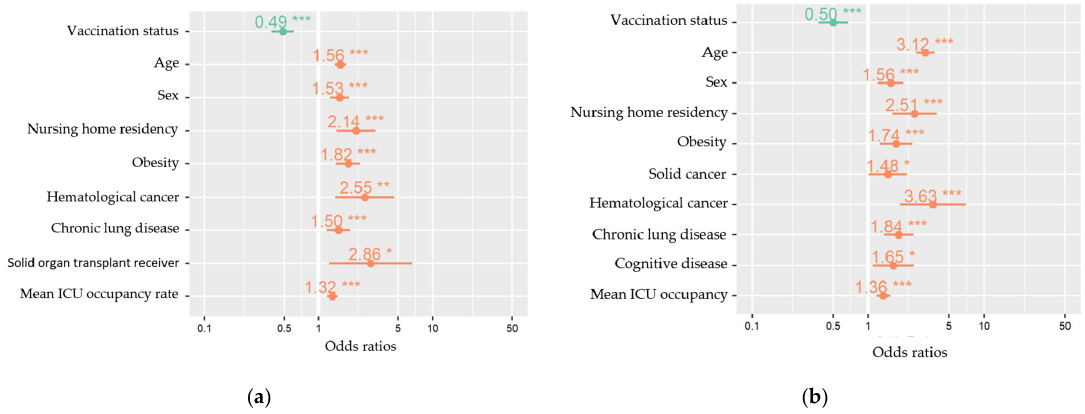
Figure A1. Multivariable mixed-effects models for explanatory variables (fixed effects) of severe COVID-19 ( a ) and in-hospital death ( b ) among hospitalized COVID-19 patients, COVID-19 clinical hospital surveillance. The following fixed effects were retained in the models obtained after stepwise backward elimination of non-significant ( p < 0.05) variables: vaccination status (primary vaccination course compared to unvaccinated), age (years), sex (male compared to female), nursing home residency, obesity, hematological cancer, chronic lung disease, and mean ICU occupancy rate (%). For the outcome severe COVID-19 ( a ), solid organ transplantation was additionally retained and for in-hospital death ( b ) additionally cognitive disease was retained. Hospital was added as a random effect to the model. ICU = intensive care unit. * p < 0.05, ** p < 0.01, *** p < 0.001.